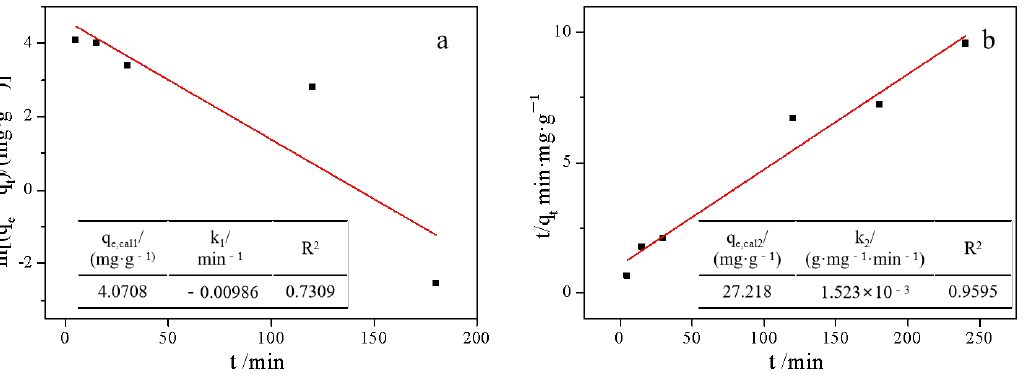
Figure 9. Pseudo-first-order kinetic ( a ) and pseudo-second-order kinetic ( b ) fitting curves for VeH8.